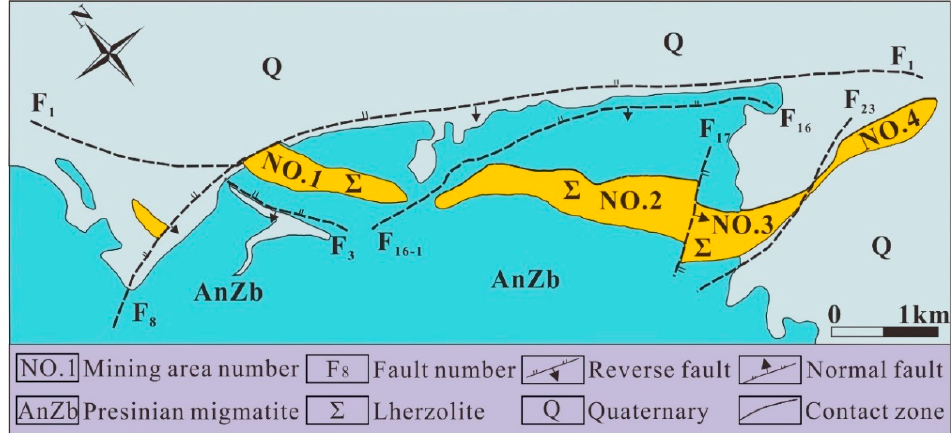
Figure 1. Engineering geologic map of Jinchuan mine [39].